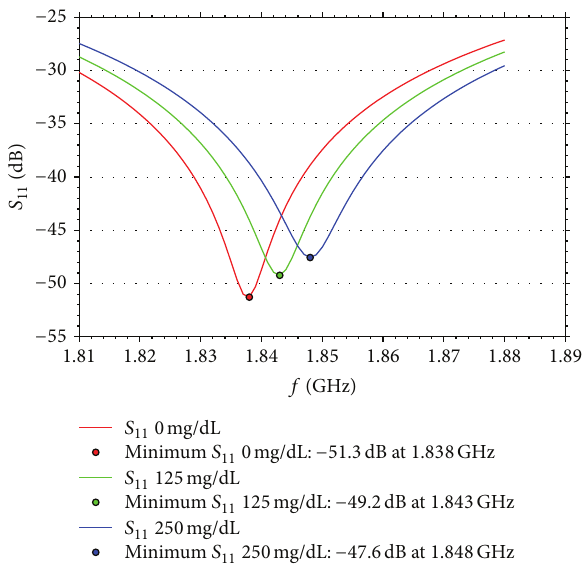
Figure 4: Computed 𝑆 11 of the sensor with container virtually filled with physiological saline [15] with different glucose concentrations.